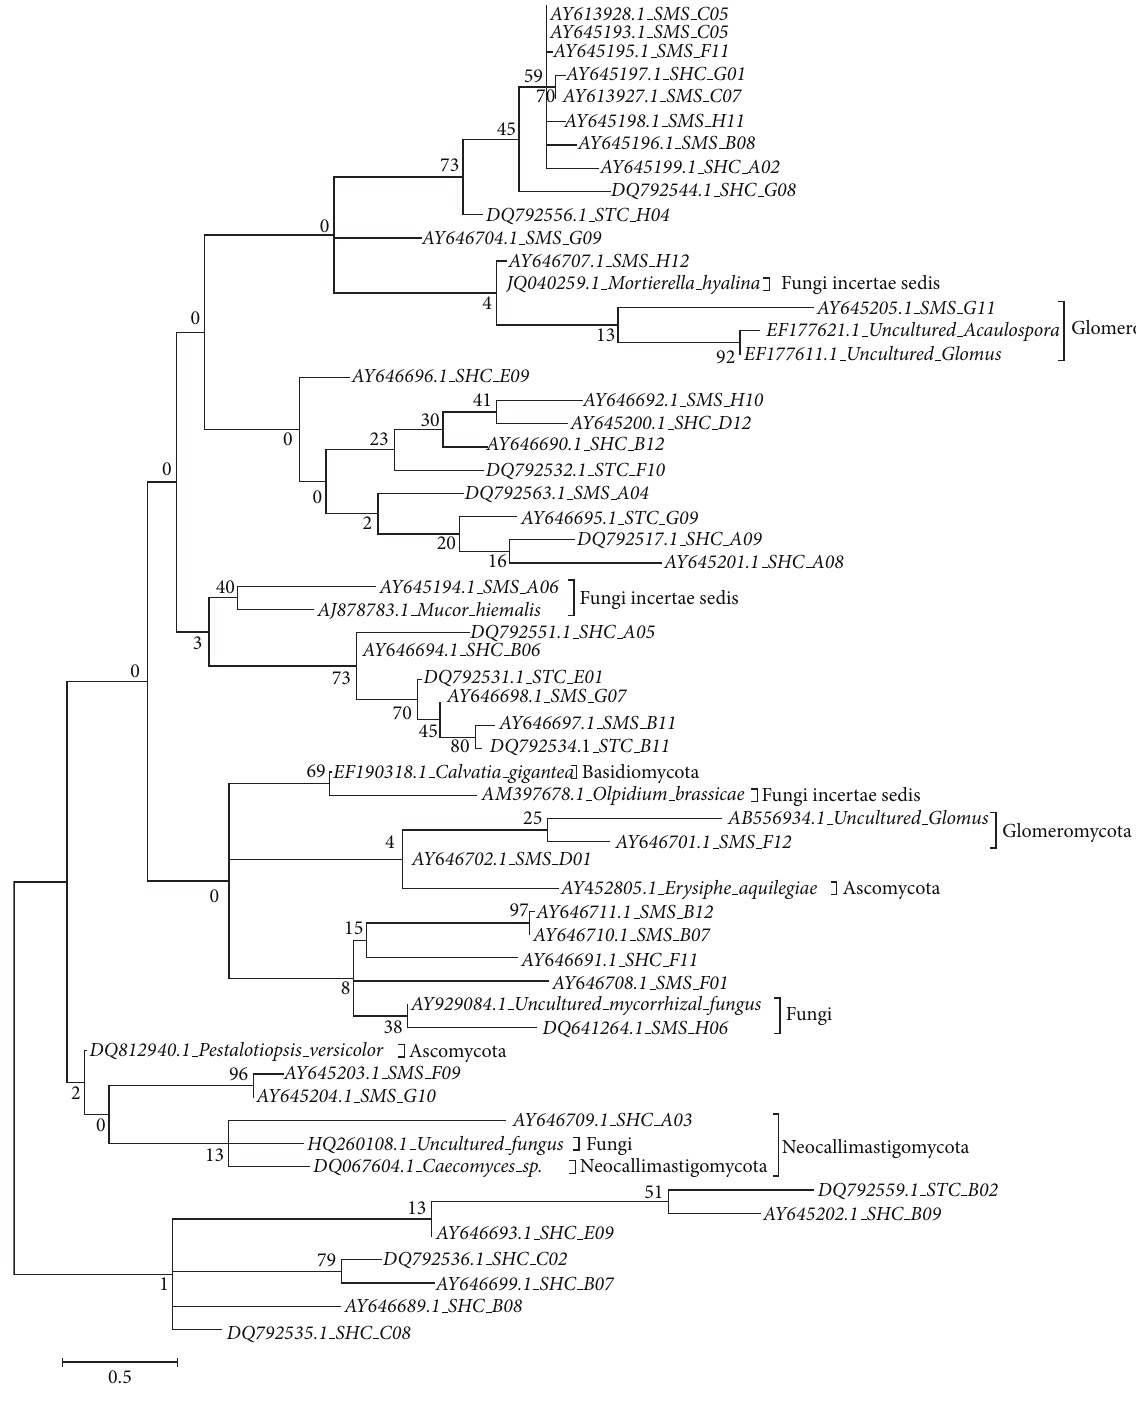
Figure 1: Molecular phylogenetic analysis by maximum likelihood